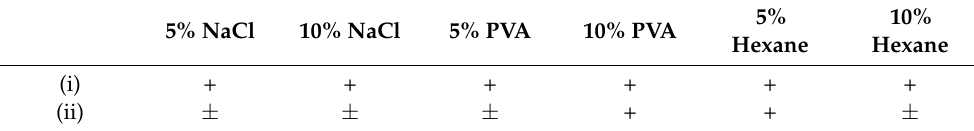
Table 5. Symbolic description of prostheses obtained for various porogens ( n =